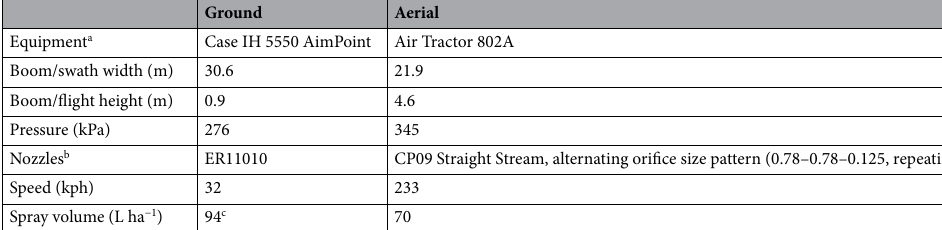
Table 4. Application parameters from the ground and aerial application equipment used in the field spray drift experiment. a Sprayer manufacturer information: Case IH 5550 AimPoint, CNH Industrial America, LLC. Burr Ridge, IL 60,527 USA; Air Tractor 802A, Air Tractor Inc., Olney, TX 76,374 USA. b Nozzle